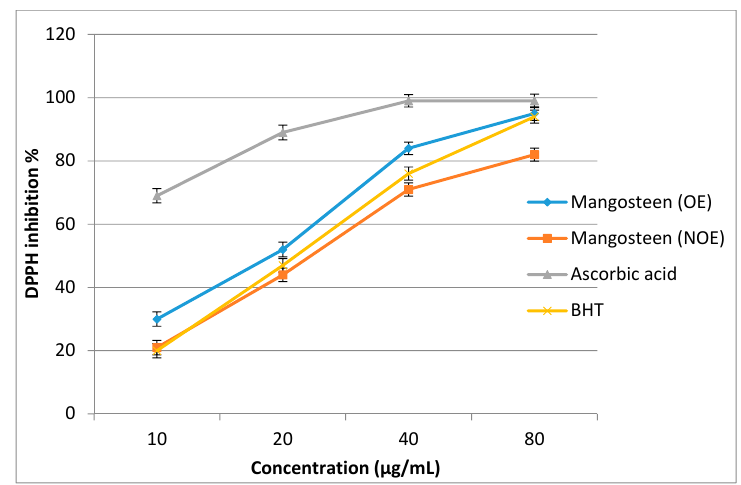
Figure 5. The 2,2-diphenyl-1-picryl-hydrazyl-hydrate (DPPH) activity of optimized extract (OE) and non-optimized extract (NOE) from mangosteen pericarp. Bars indicate standard errors of the means. Table 5. The ferric reducing antioxidant potential (FRAP) activity of optimized extract (OE) and non-optimized extract (NOE) from mangosteen.